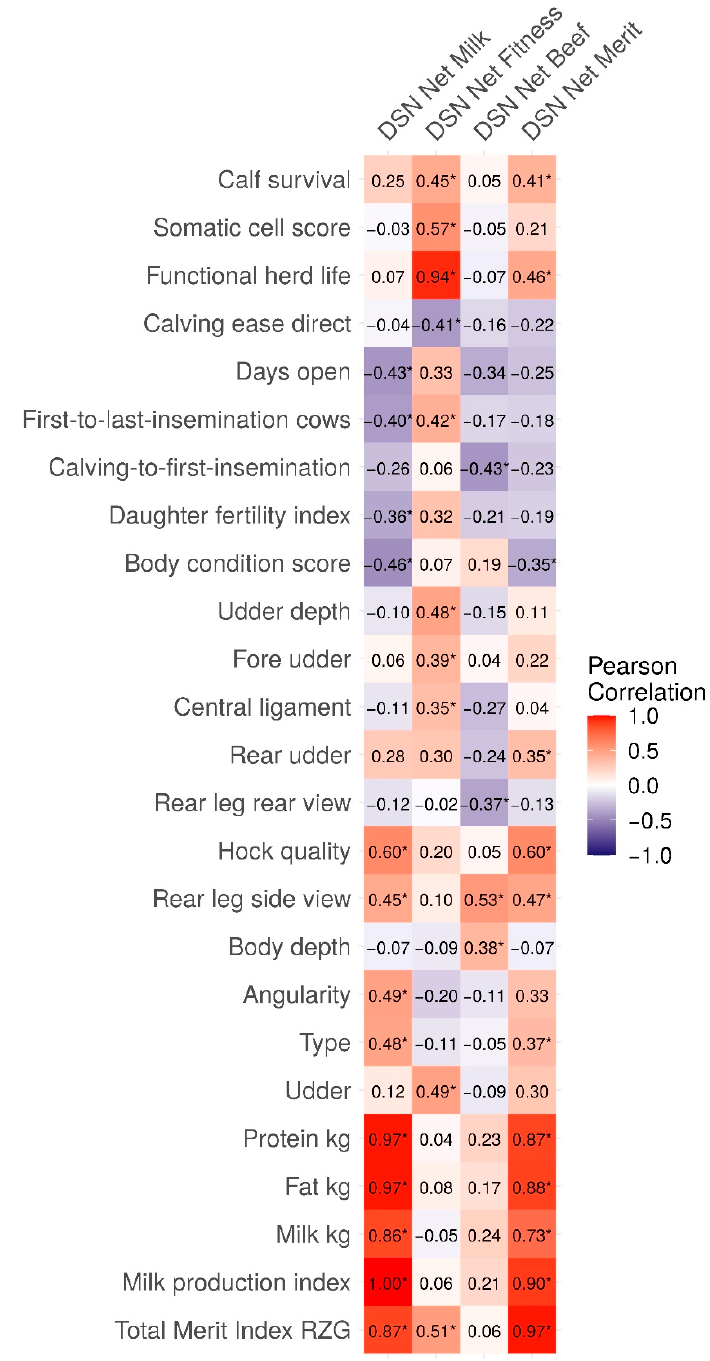
Figure 2. Heatmap of Pearson’s correlation coefficients between DSN Net Merit and its sub-indices with EBVs from the breeding evaluation in August 2019. Only EBVs with at least one significant correlation ( P < 0.05) to DSN Net Merit or a sub-index are shown. Significant correlations ( P < 0.05) are highlighted with an asterisk *. Correlation coefficients are highlighted in a gradient from blue for perfect negative ( r = − 1) over white for no correlation ( r = 0) to red for perfect positive correlation ( r =